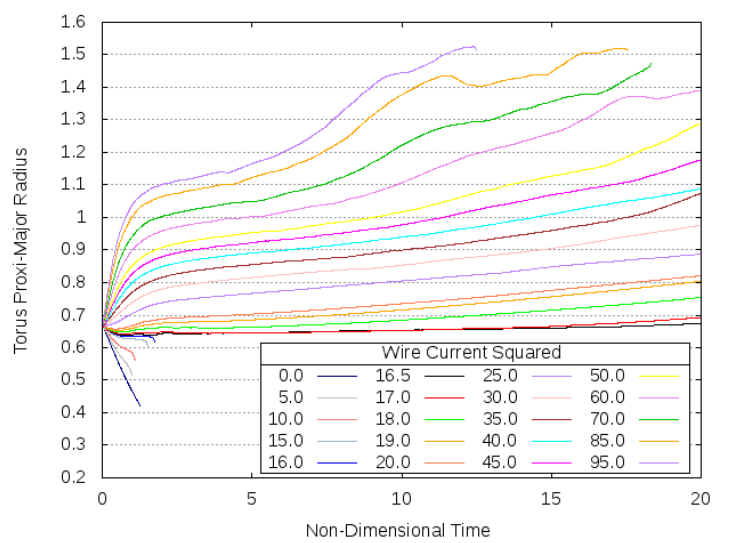
Figure 2. Plots of the proxi-major torus radii ˜ R over non-dimensional time t from initial state, ˜ R ≡ R = 0.66, for a selection of different wire currents, i 2